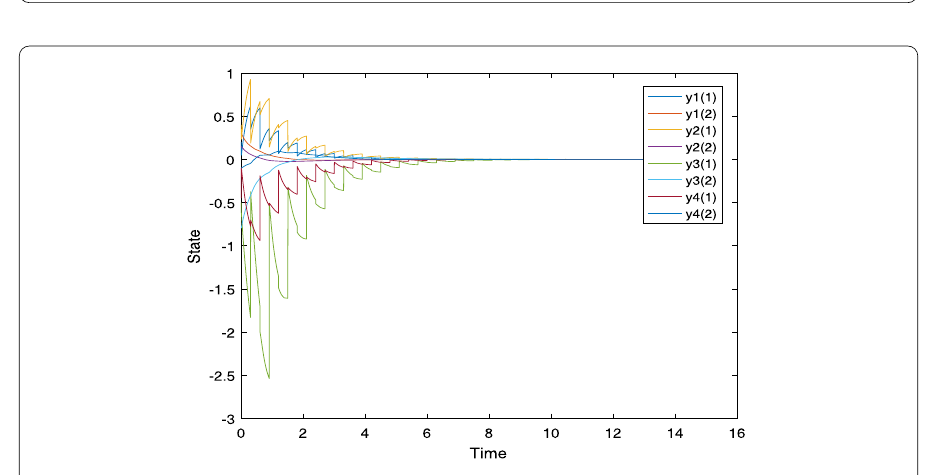
Figure 8 State trajectory of (4.2) with